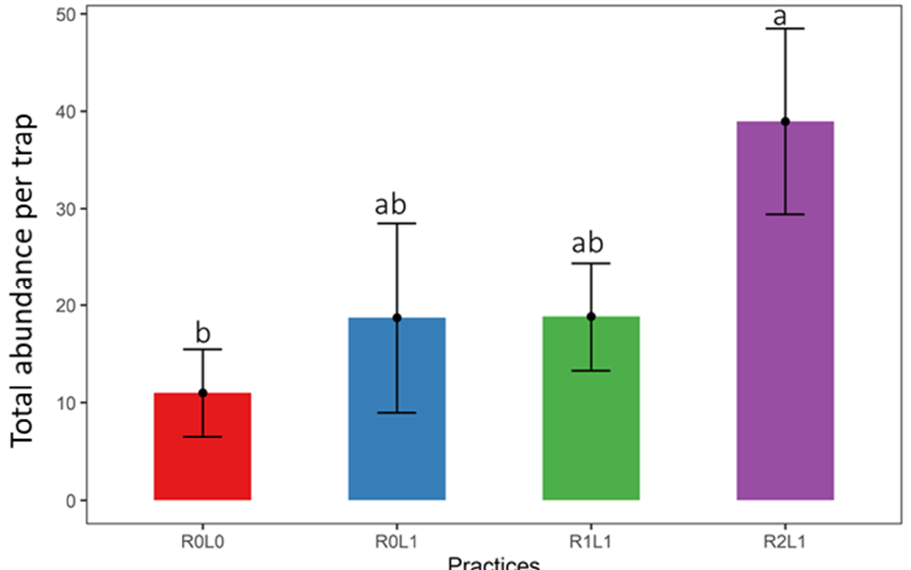
Figure 2. Variation in total abundance of springtails between practices. Vertical lines represent standard errors for each practice ( n = 18). Different letters indicate significant differences according to the Tukey test. R0L0—no residue or legume in the plot, R0L1—Legume ( Pueraria phaseoloides ) only, R1L1—Legume + stump + leaf + fine branches, R2L1–R1L1 + trunk.